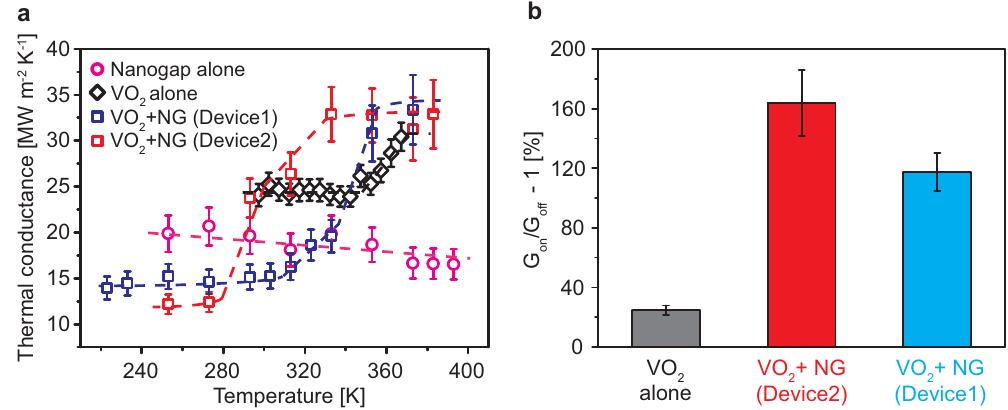
Figure 3. ( a ) Thermal conductance versus temperature plots of the nanogap, VO 2 film alone, “VO 2 + NG” Device1, and “VO 2 + NG” Device2, respectively. 10% errors are estimated considering the error of thicknesses and measurements. The dashed lines are added as guides to the eye. ( b ) Comparison of thermal switching performance of VO 2 film, “VO 2 + NG” Device2, and “VO 2 + NG” Device1 based on ( a